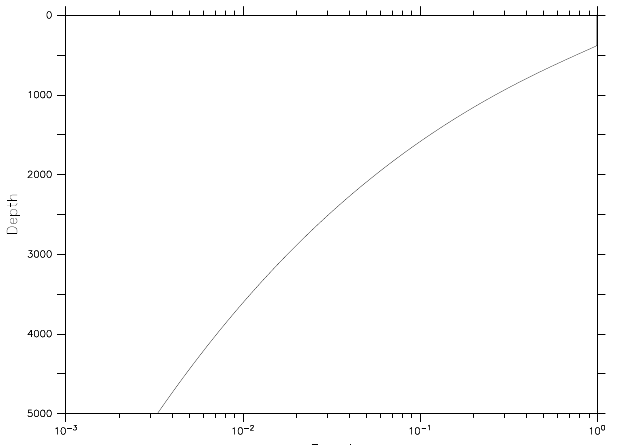
Figure 5. Sediment source of iron as a function of depth. This plot displays the vertical variation of Fsed (see Eq. 85 for the definition of this factor).